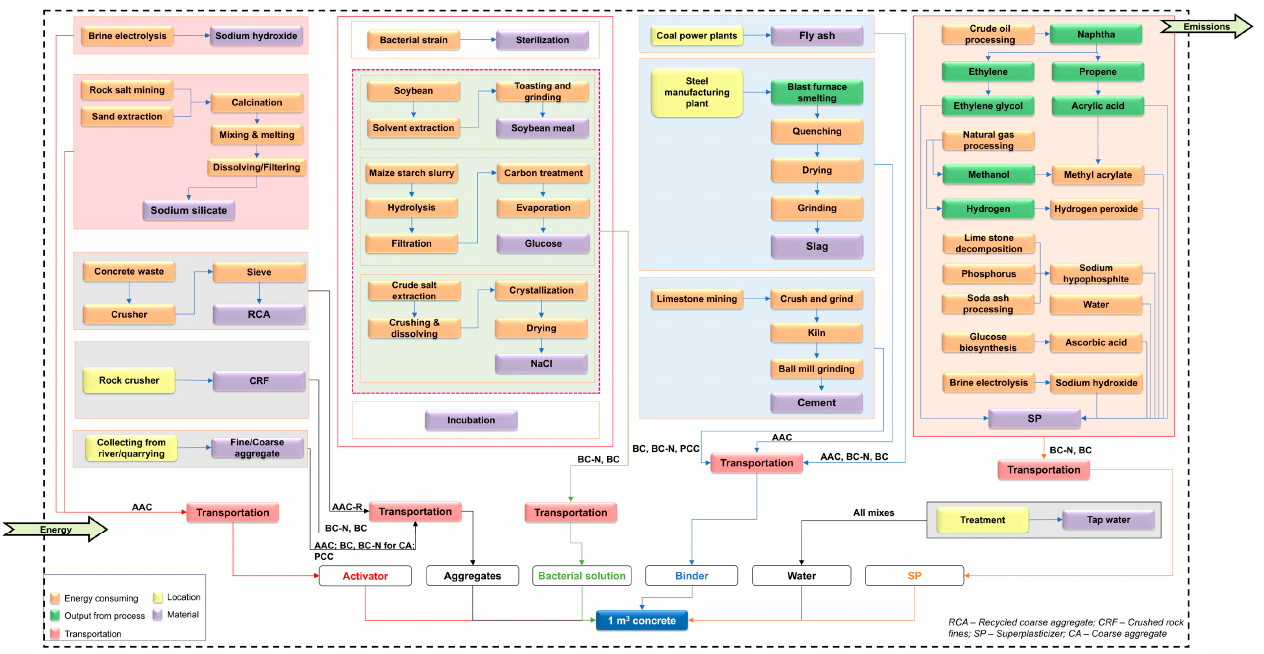
Figure 3. System boundary for cradle-to-gate